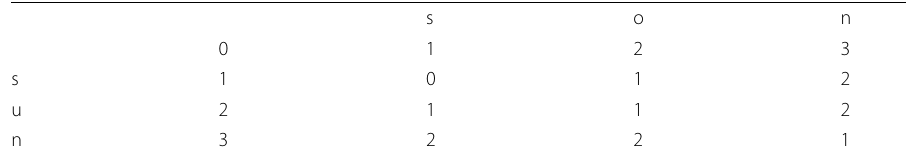
Table 4 The end